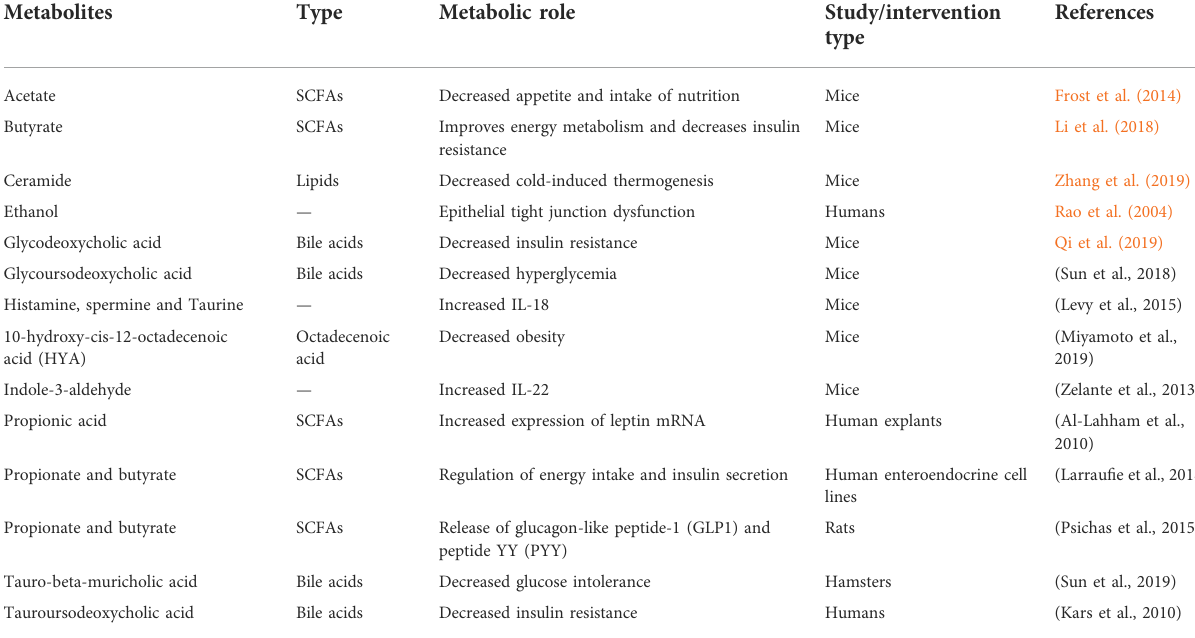
TABLE 2 The implications of microbiota-derived metabolites in metabolic